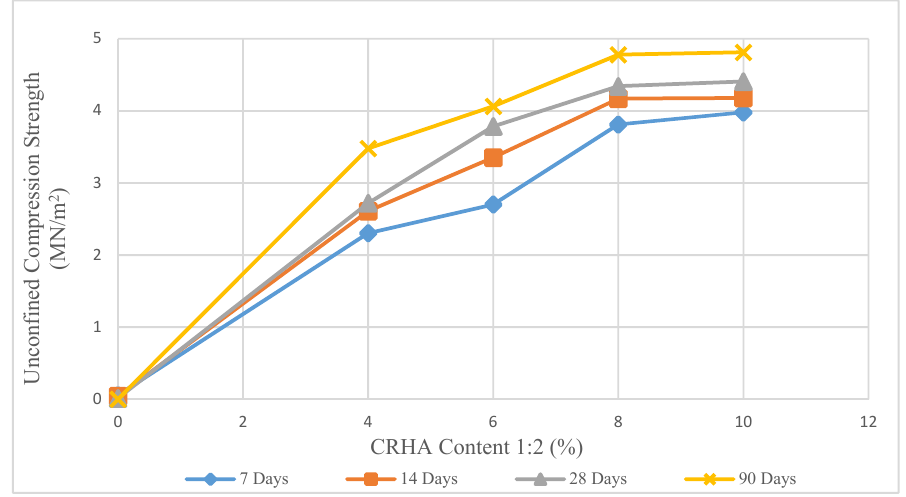
Figure 8. Effect of CRHA (1:2) content on unconfined compression strength.